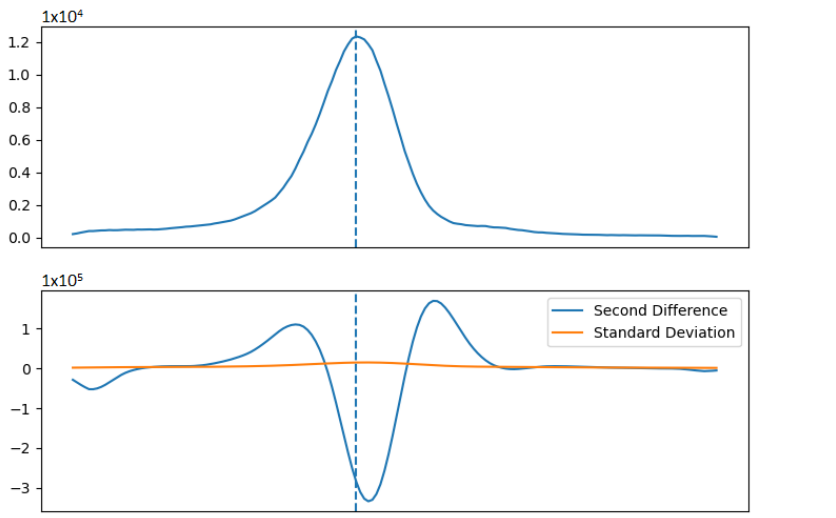
Figure 2. Schematic of a spectral peak ( top ) with the second derivative and its standard devia- tion ( bottom